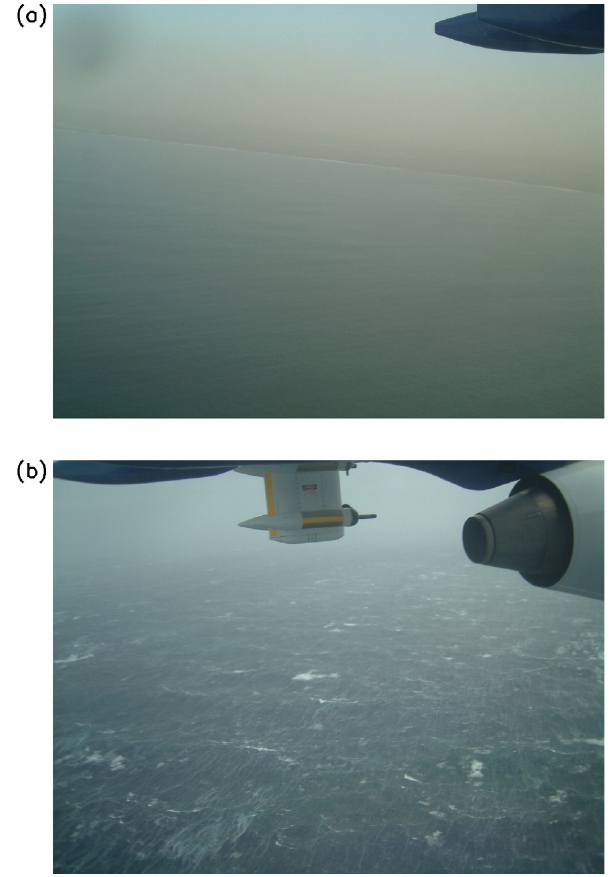
Fig. 3. Photos taken aboard the aircraft showing (a) dust in the wake and (b) the rough sea-surface in the jet.